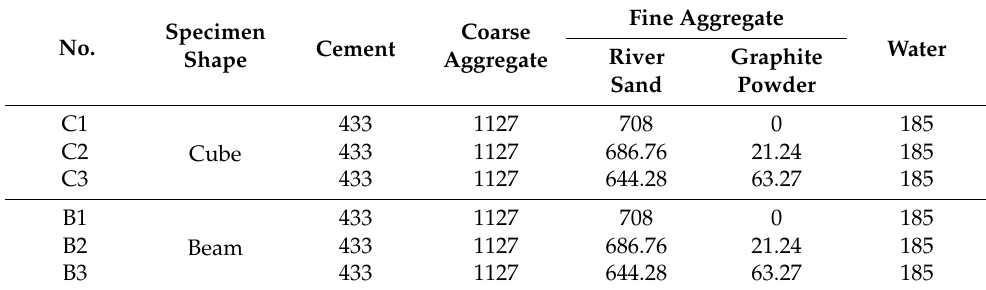
Table 3. Mix proportion of the concrete/kg/m 3.